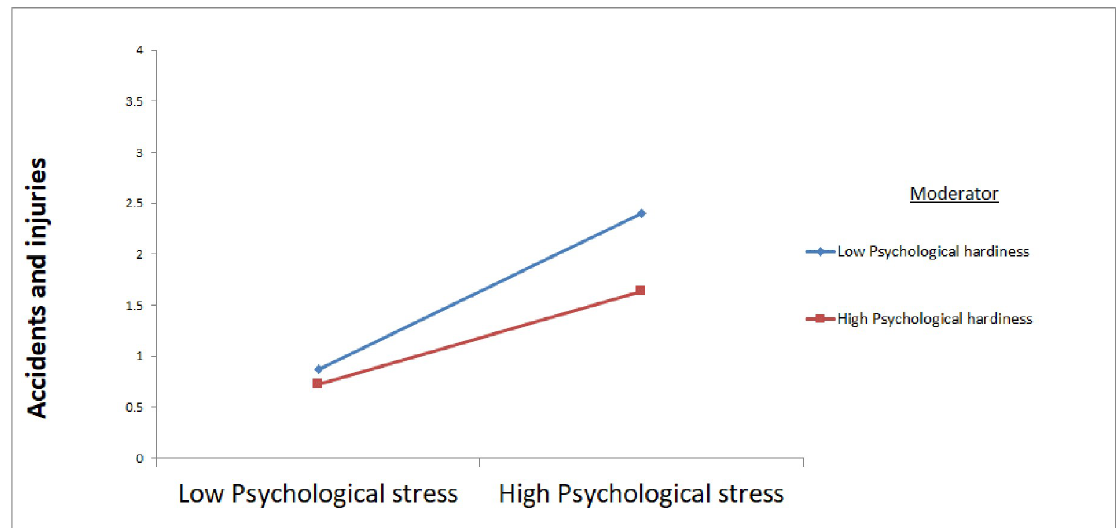
Fig 3. Moderation of psychological hardiness on stress and accidents and injuries.